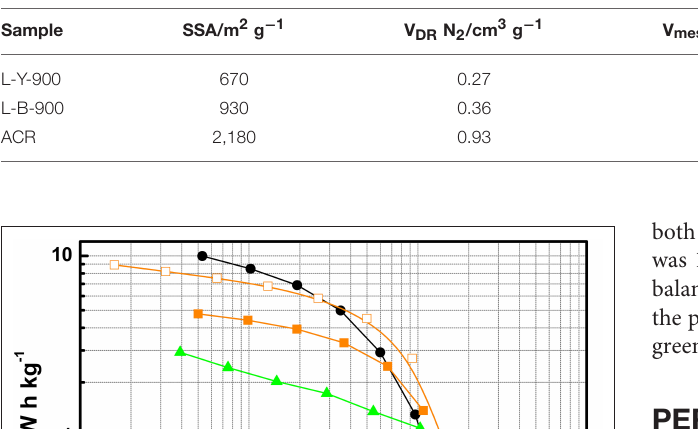
TABLE 5 | Porous texture and surface chemistry characterization of all samples.